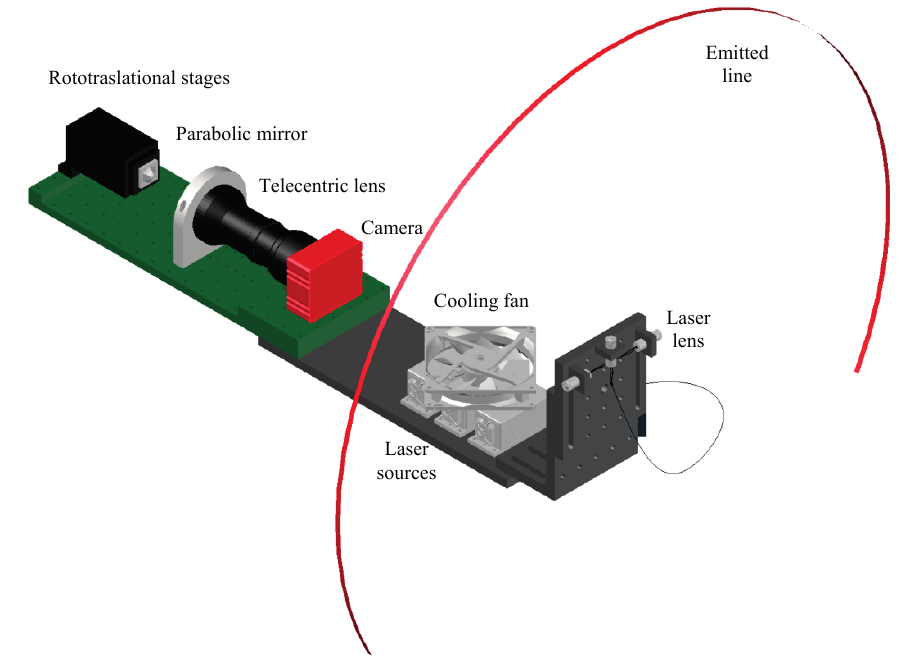
Figure 1. Sketch of the presented laser profilometer. Note the parabolic mirror is mounted onto micrometric rototranslational stages, whereas the camera is fastened on the metallic stand. Lasers are placed across from the parabolic mirror, behind the